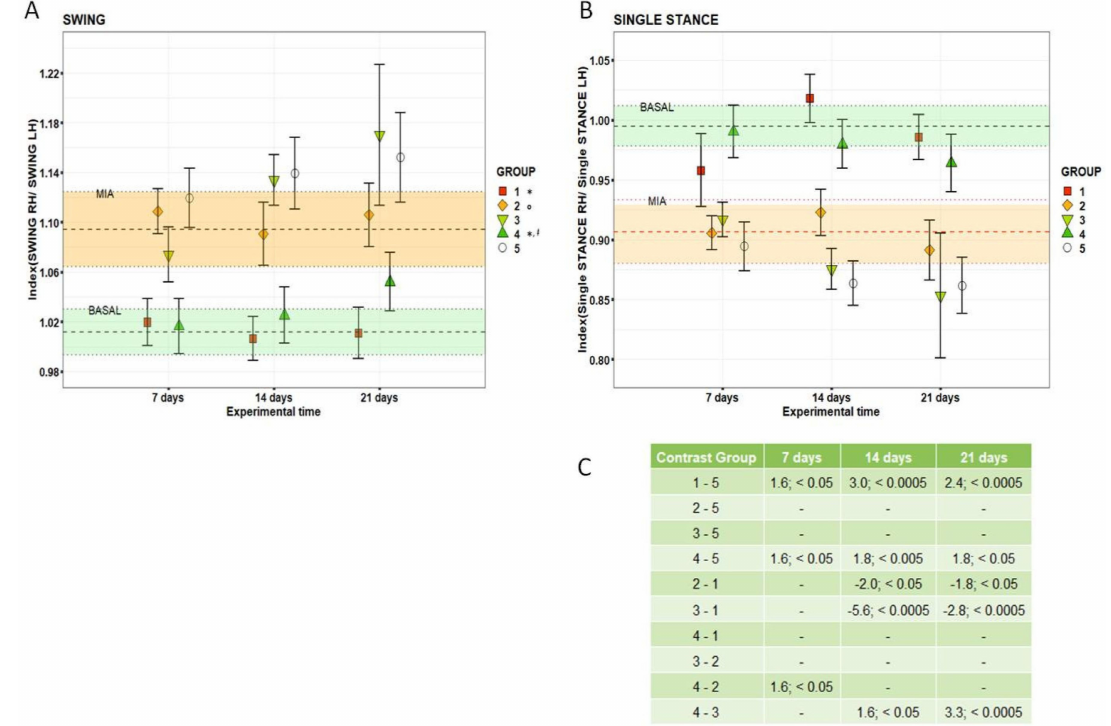
Figure 3. CatWalk results. ( A ) Dot plots of Swing results for each treatment measured at each experimental time. Dots indicate mean and error bars indicate SE. The selected LMM models showed significant e ff ects of treatment (F = 5.35, p < 0.005) and experimental (F = 14.43, p < 0.0005) time factors. Tables report the pairwise comparisons ( d -value; p -value). Post-hoc pairwise comparisons (1 symbol: p < 0.05; 2 symbols: p < 0.005; 3 symbols: p < 0.0005): * All treatment groups versus NaCl. ◦ HY-CTL, RV2 and RV4.5 versus TA. # RV2 and RV4.5 versus HY-CTL. § RV4.5 versus RV2. ( B ) Dot plots of Single Stance for each treatment group measured at each experimental time. Single stance values (mean and SE) measured at baseline (BASAL) and seven days after MIA (MIA) are reported as green and orange zones. Dots indicate mean and error bars indicate SE. The selected LMM models showed significant interaction of treatment and experimental time factors (F = 6.71, p < 0.0005). ( C ) Single Stance pairwise comparisons ( d -value; p -value). Group 1: TA; group 2: HY-CTL; group 3: RV2; group 4: RV4.5; group 5: